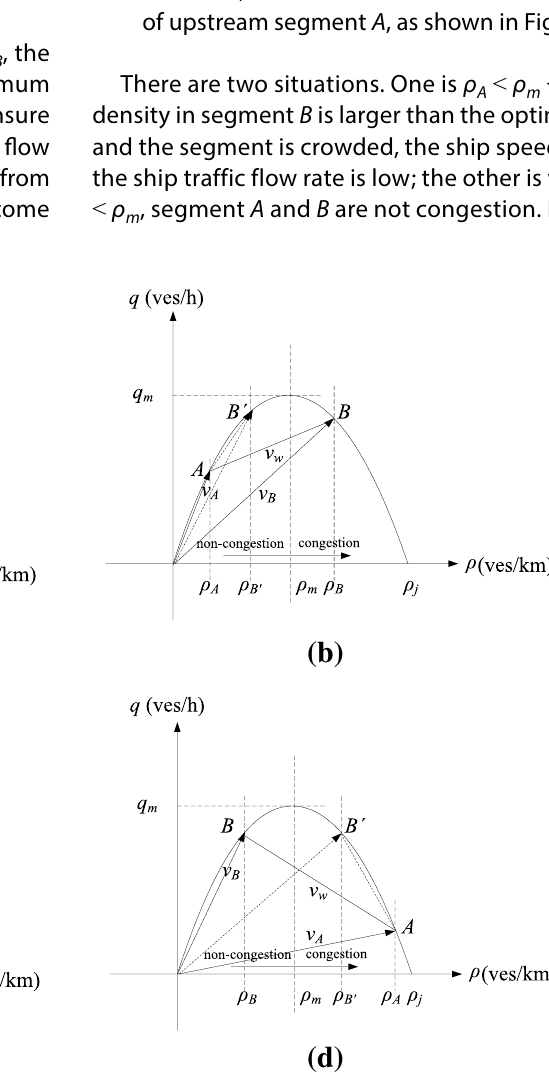
> 0. b The second case when v w